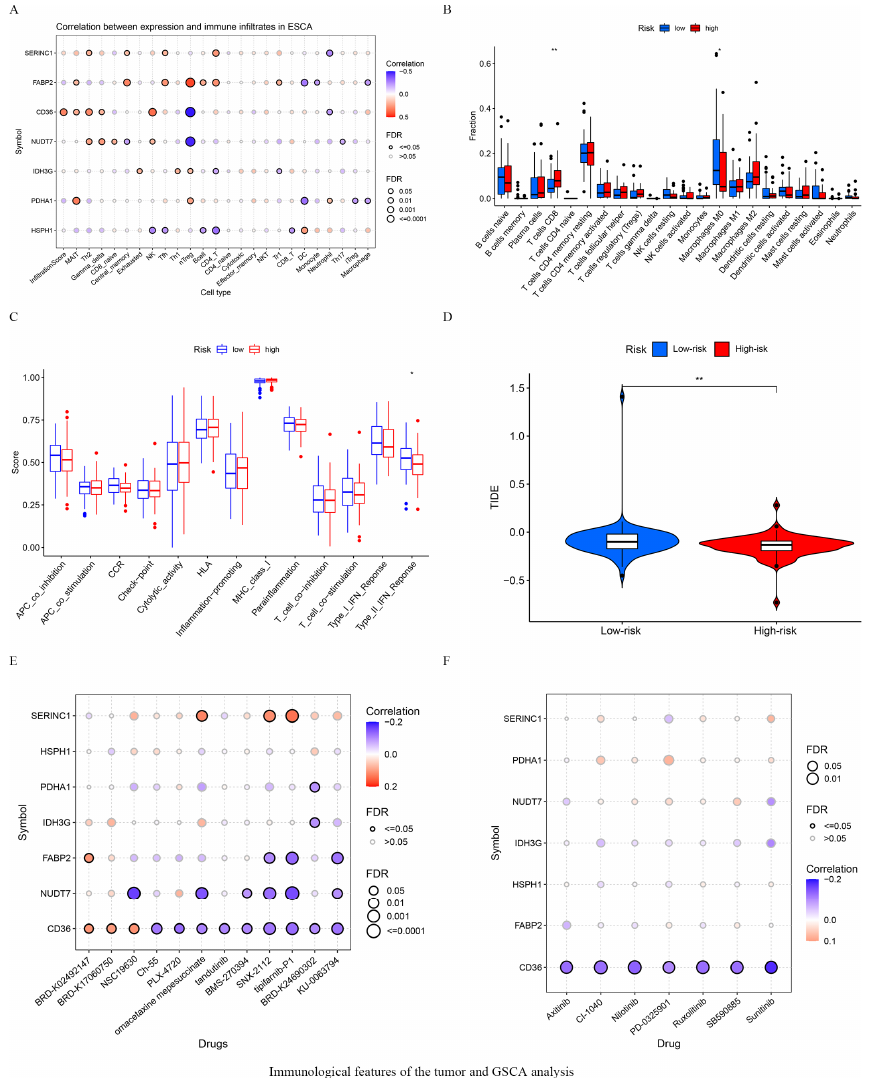
Figure 5 . Immunological features of the tumor and GSCA analysis. ( A ) The correlation between 7 key genes and infiltrated immune cells. Different color circle denote different P value, the smaller the P value, the larger the circle. ( B ) The ratios of 22 immune cell types in high- and low-risk pa- tients.The black circle represents a single individual. ( C ) Immune function difference in high- and low-risk group in ESCA patients. ( D ) Comparison of Immunotherpy response between high- and low-risk patients. ( E ) Correlation between CTRP drug sensitivity and 7 key gene expressions. ( F ) Correlation between GDSC drug sensitivity and 7 key gene expressions. *p < 0.05, **p < 0.01.